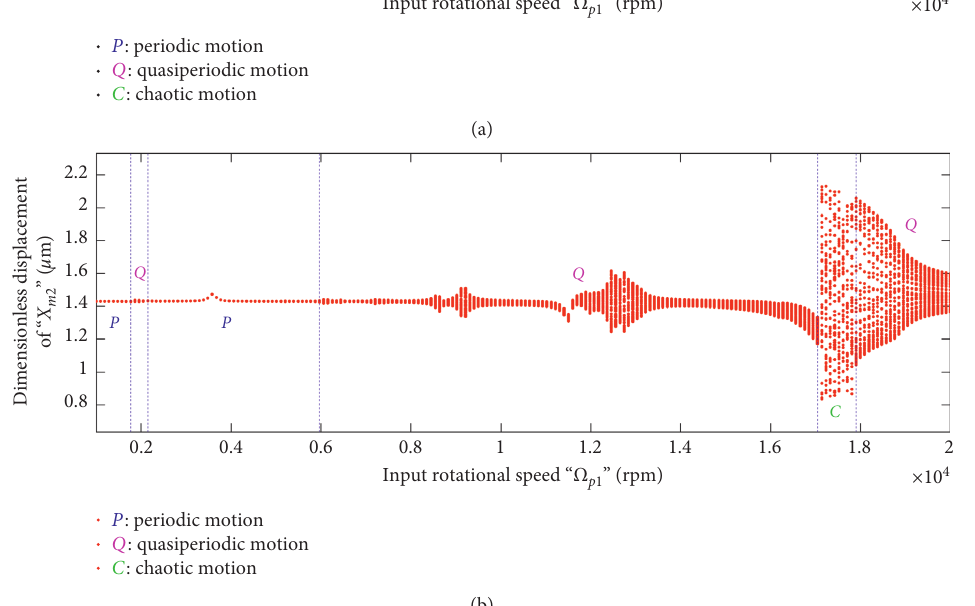
Figure 2: Forward bifurcation diagrams of system using Ω